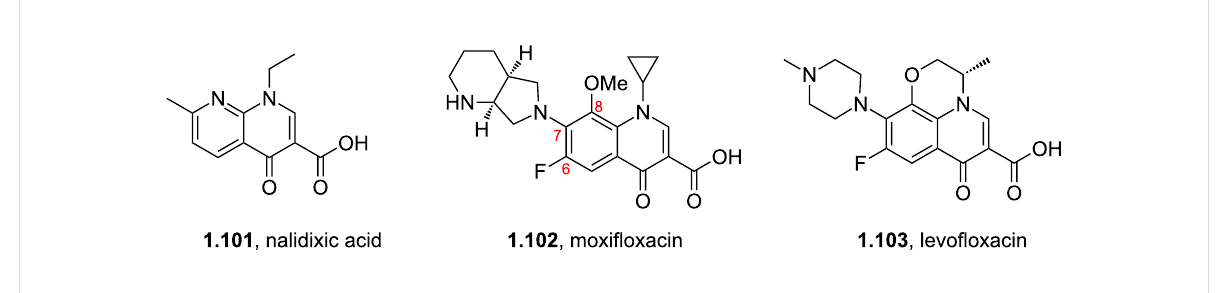
( 1.103 , Levaquin) are two third-generation fluoroquinolone antibiotics which also appear amongst the top selling